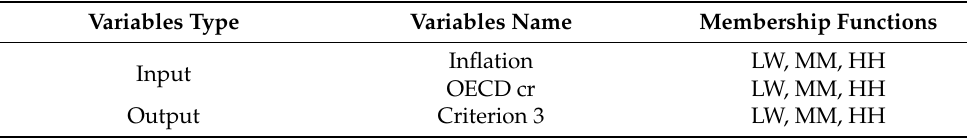
Table 8. Third Type-1 fuzzy system inflation and OECD country risk